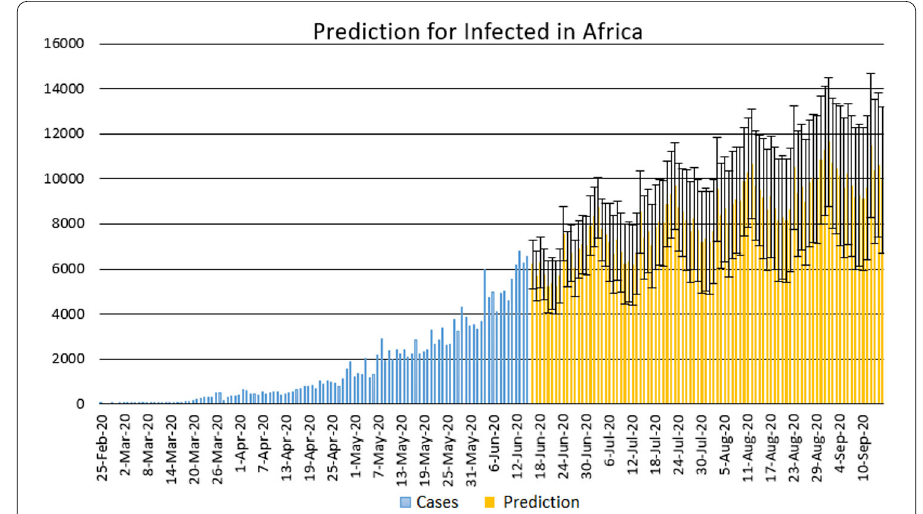
Figure 11 Prediction for the infected in Africa using Forecast Sheet